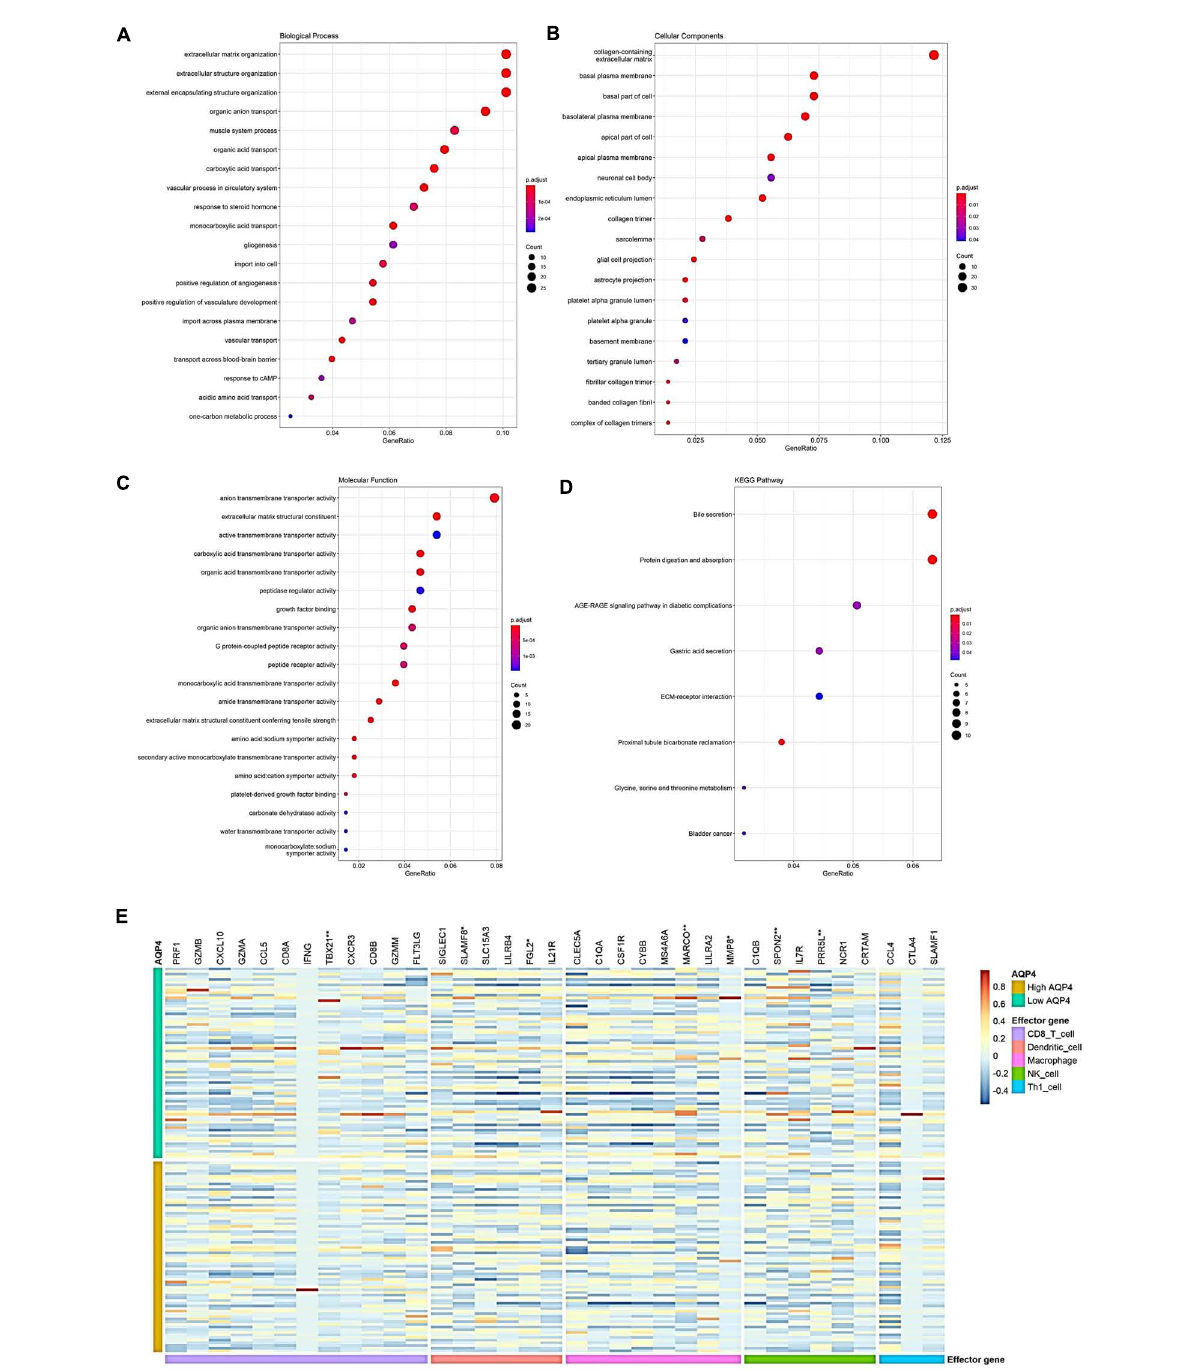
FIGURE4 Analysis of differential gene functions, pathway enrichment, and tumor-related immune cell effector genes downstream of the AQP4 gene in glioma. (A–D) Differential gene function and pathway enrichment analysis of AQP4 gene between high and low-risk groups. (E) Heat map of the relationship between high and low AQP4 gene groups and tumor-associated immune cell effector genes. * p < 0.05, ** p <